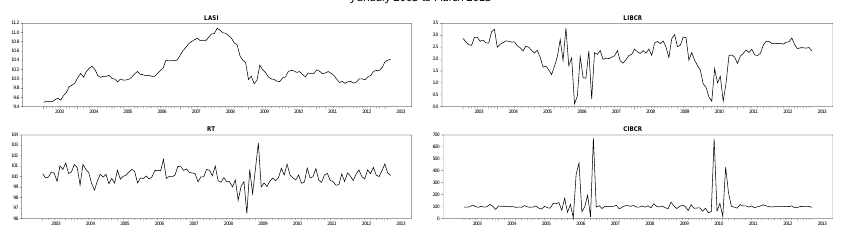
FIGURE 1: Time plot of NSE Returns vs. Change in interbank call rate